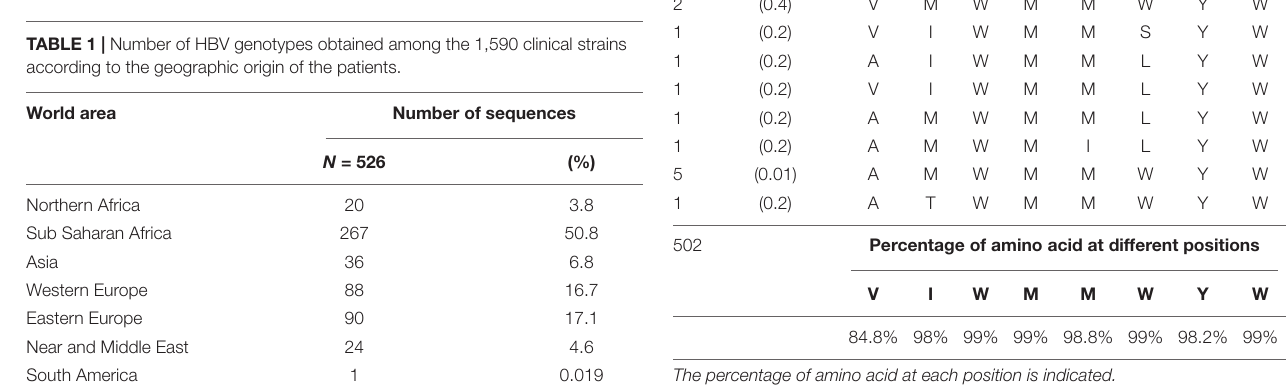
The percentage of amino acid at each position is